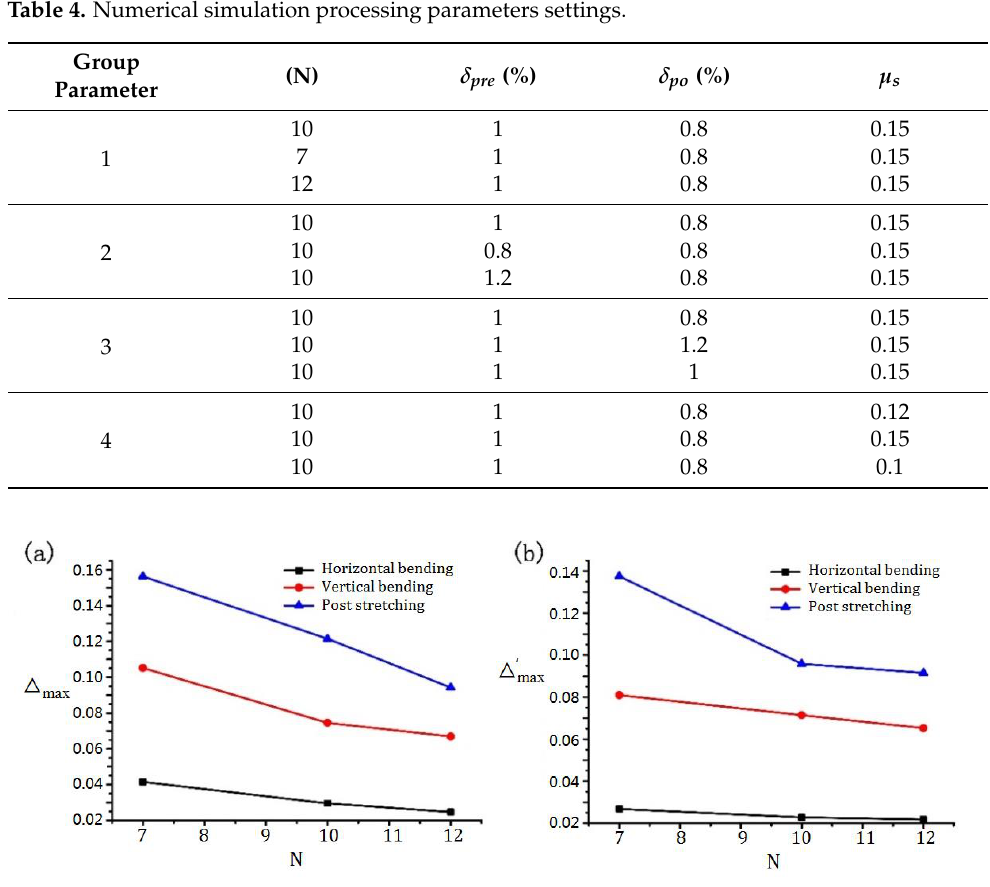
Figure 4. The effect of the number of multi-point dies on thinning. ( a ) Outer web. ( b ) Inner web.